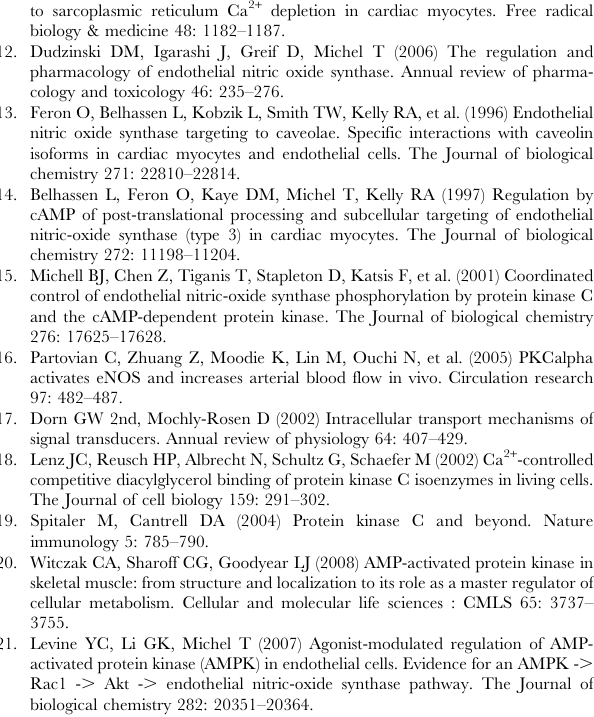
Figure S1 In Panel A, cardiac myocytes were treated with hydrogen peroxide (H 2 O 2 , 25 m M) and analyzed in immunoblots